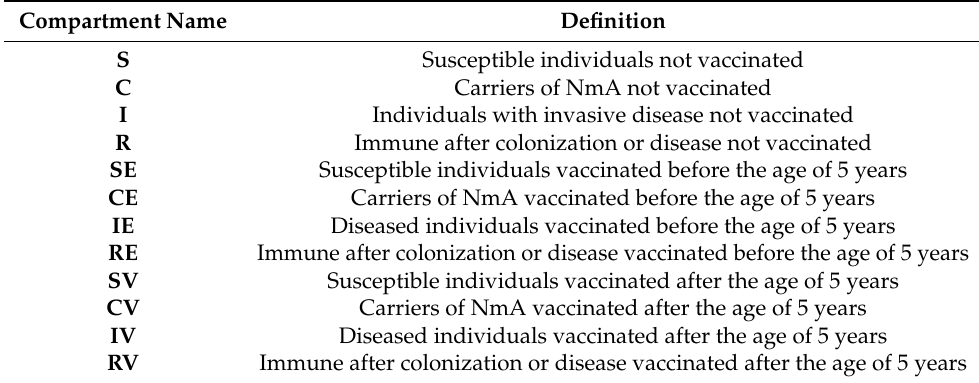
Table A1. List of the model compartments and their